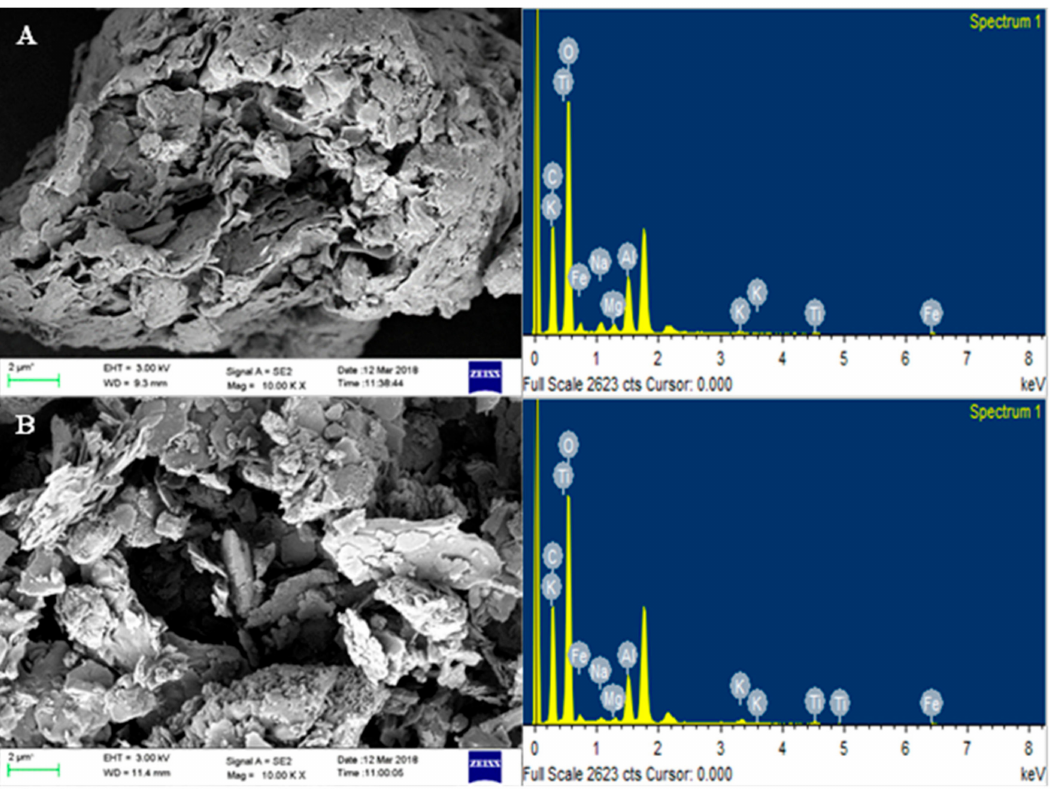
Figure 7. FESEM images and EDX spectrum of ( A ) MMT clay and ( B ) MMT/Ag nanocomposite.